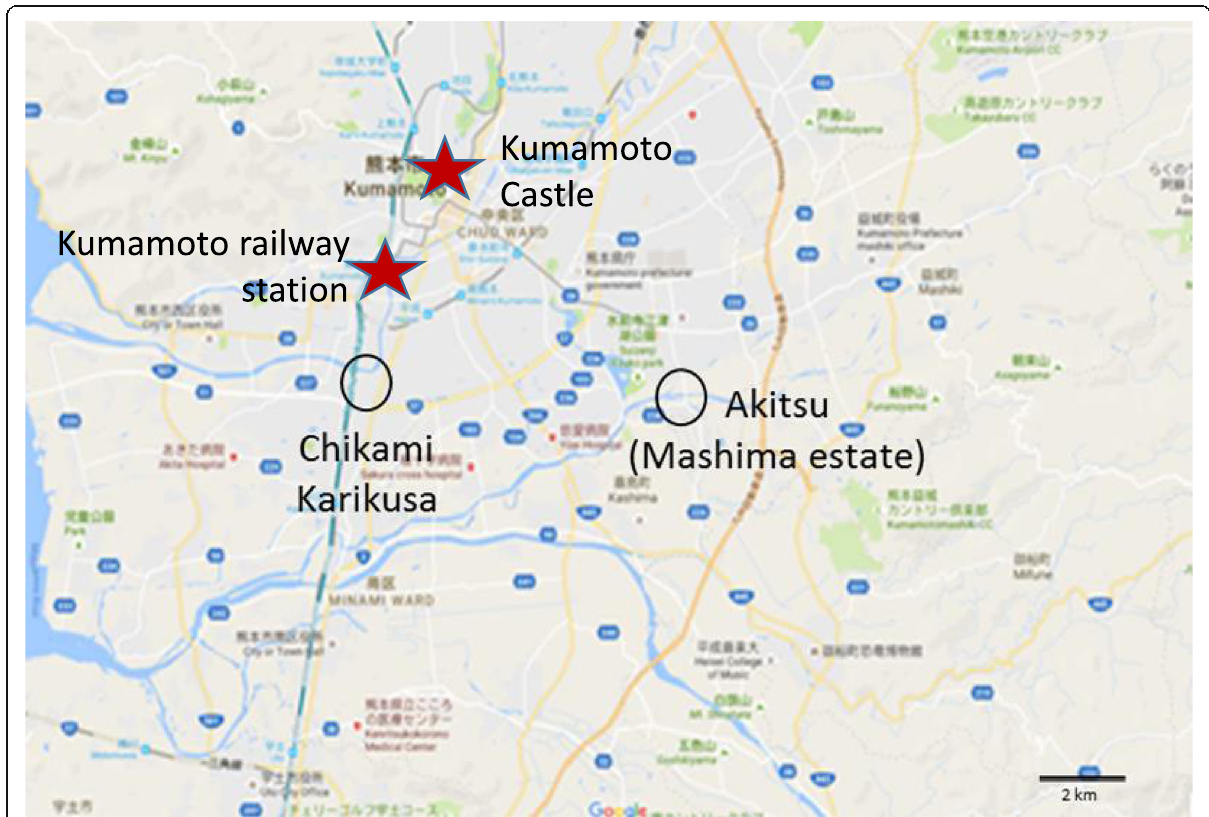
Fig. 4 Survey location